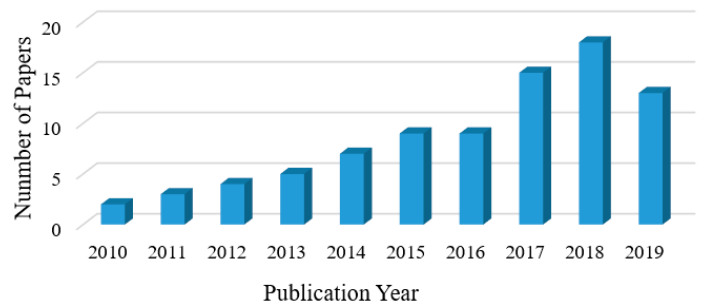
Figure 4. Distribution of selected papers according to publication year.